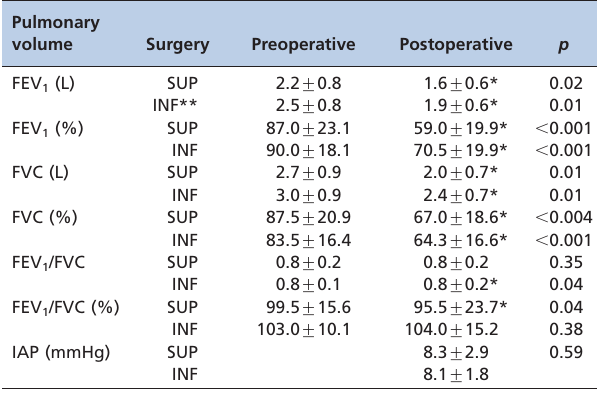
Table 1 - Pulmonary volumes and intra-abdominal pressure before and after